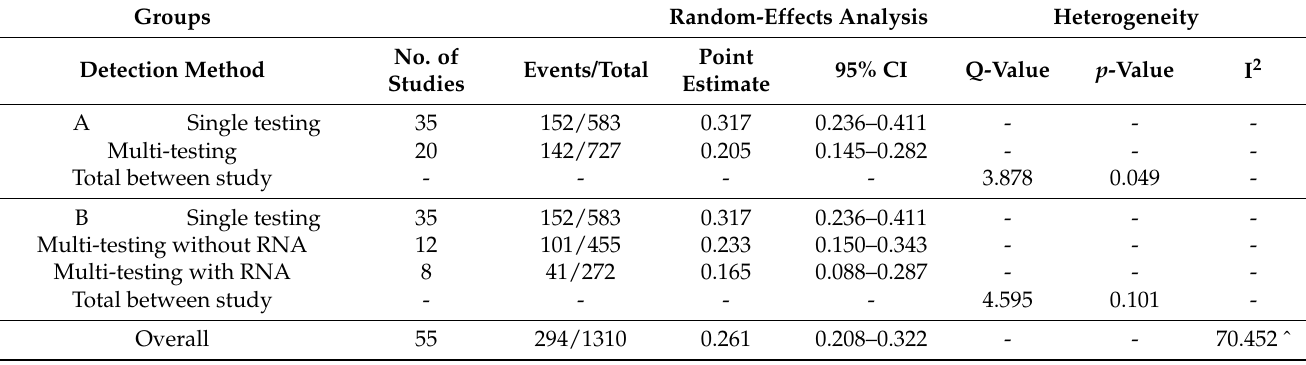
Table 2. HPV Prevalence estimates stratified by detection method. ( A ). HPV prevalence stratified by single-agent testing and multi-agent testing. ( B ). HPV prevalence stratified by single-agent testing, multi-agent testing using RNA, and all multi-agent testing not using